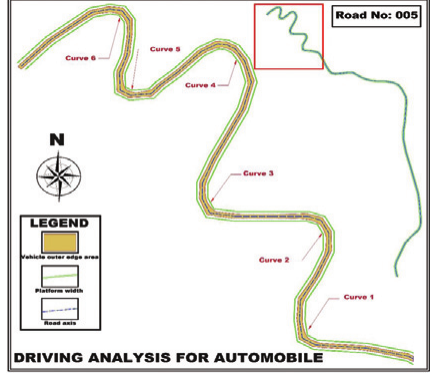
Fig. 5. Results of horizontal driving analysis for automobile